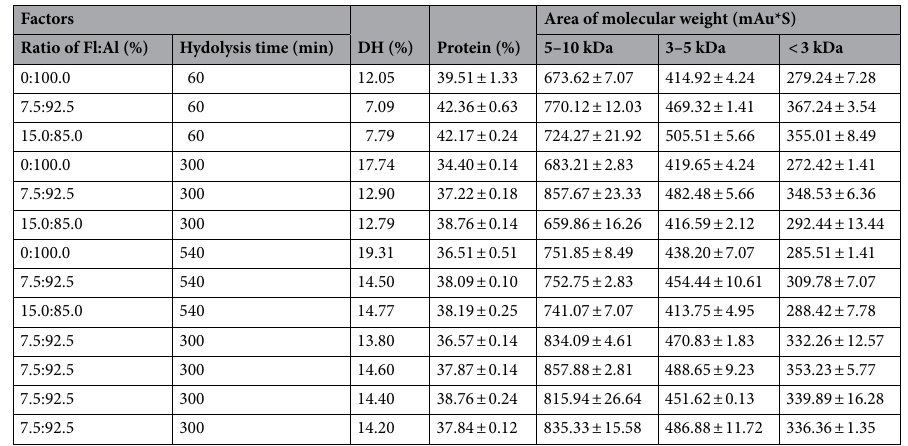
Table 1. Experimental design of factorial design parameters obtained for independent variables: X 1 (alcalase to flavourzyme ratio, w/w), X 2 (time, min) and experimental values of responses: DH (%), protein content (%) and area of molecular weight (mAU*S). Note: All values are Mean ± SD of three individual